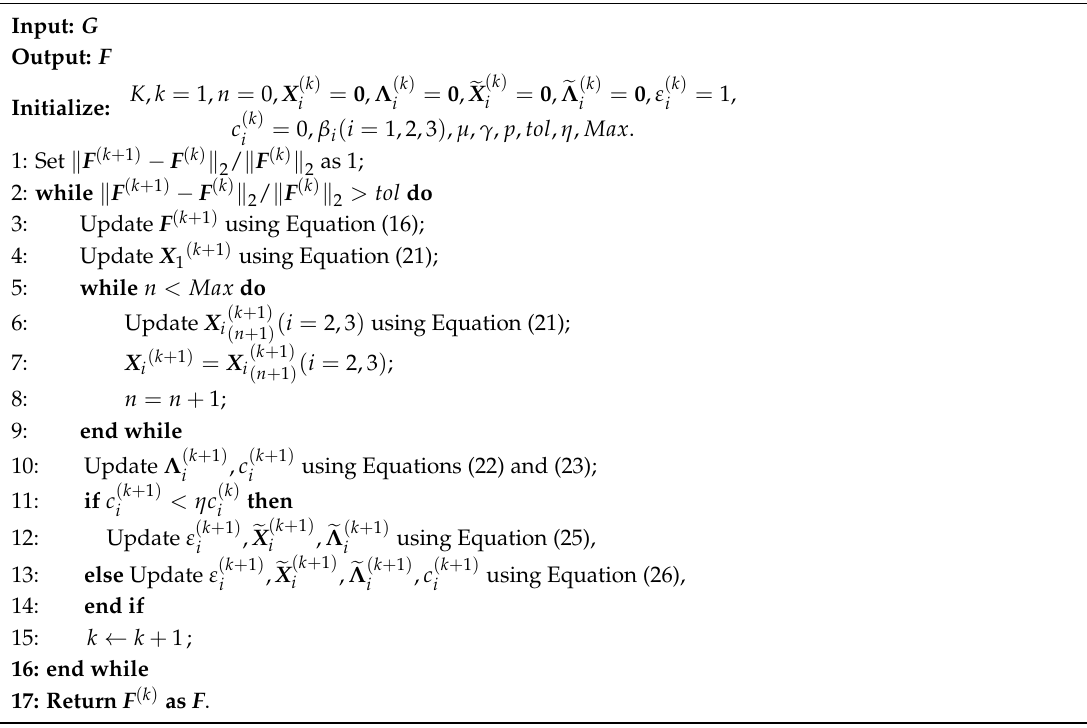
Algorithm 2 : Pseudocode GGS_LP_Fast for image